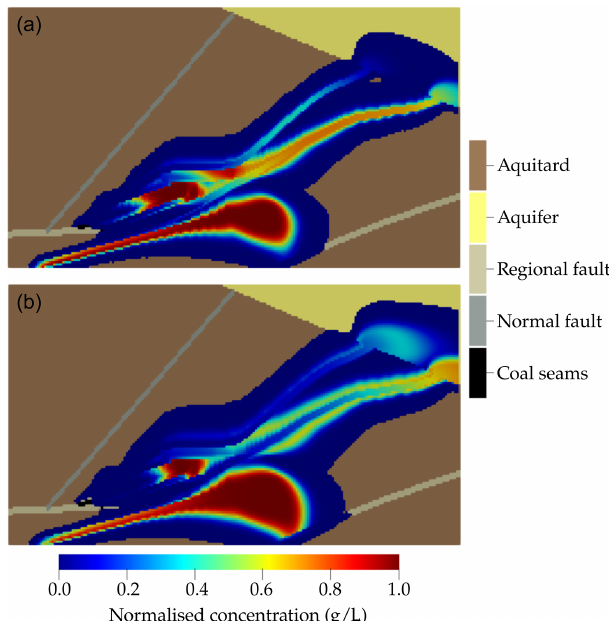
Figure 7. Simulated contaminant concentration distribution for the worst-case scenario with all hydraulic conductivities and the lateral pressure head set to their maximum values and retardation neglected after simulation times of 30 years (a) and 50 years (b)